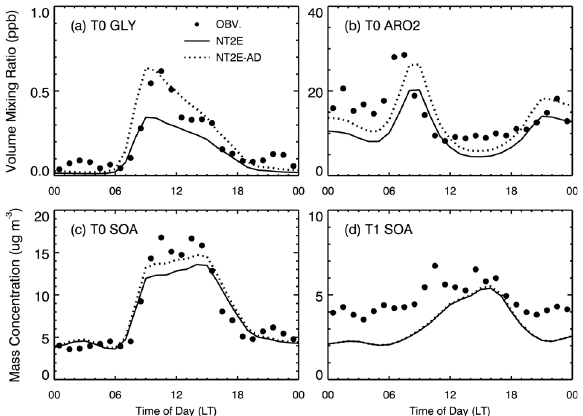
Fig. 13. Diurnal cycles of (a) glyoxal at T0, (b) ARO2 at T0, (c) SOA at T0, and (d) SOA at T1 averaged during the period from 24 to 29 March 2006. Black dots: measurements; black solid line: the NT2E-SOA model; black dotted line: NT2E-SOA model with high yield glyoxal from ARO1 and ARO2 and increased ARO2 emis-